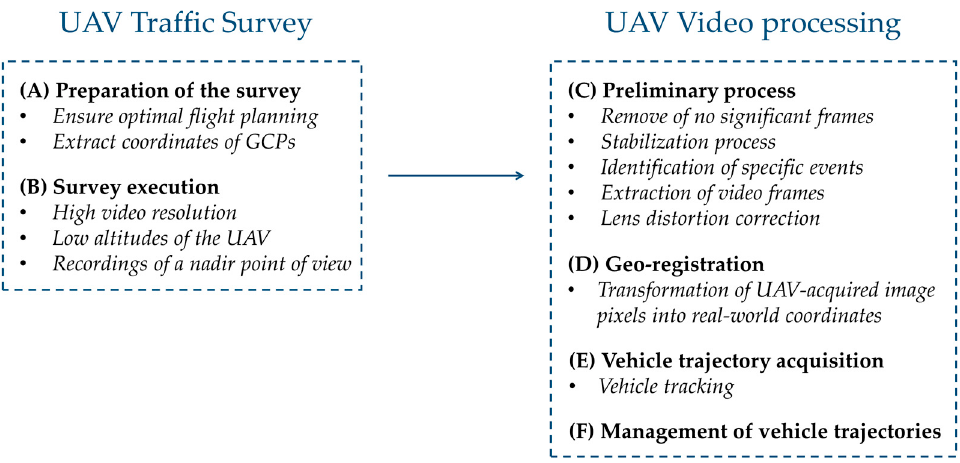
Figure 2. The discrete steps to acquire traffic data using UAVs.